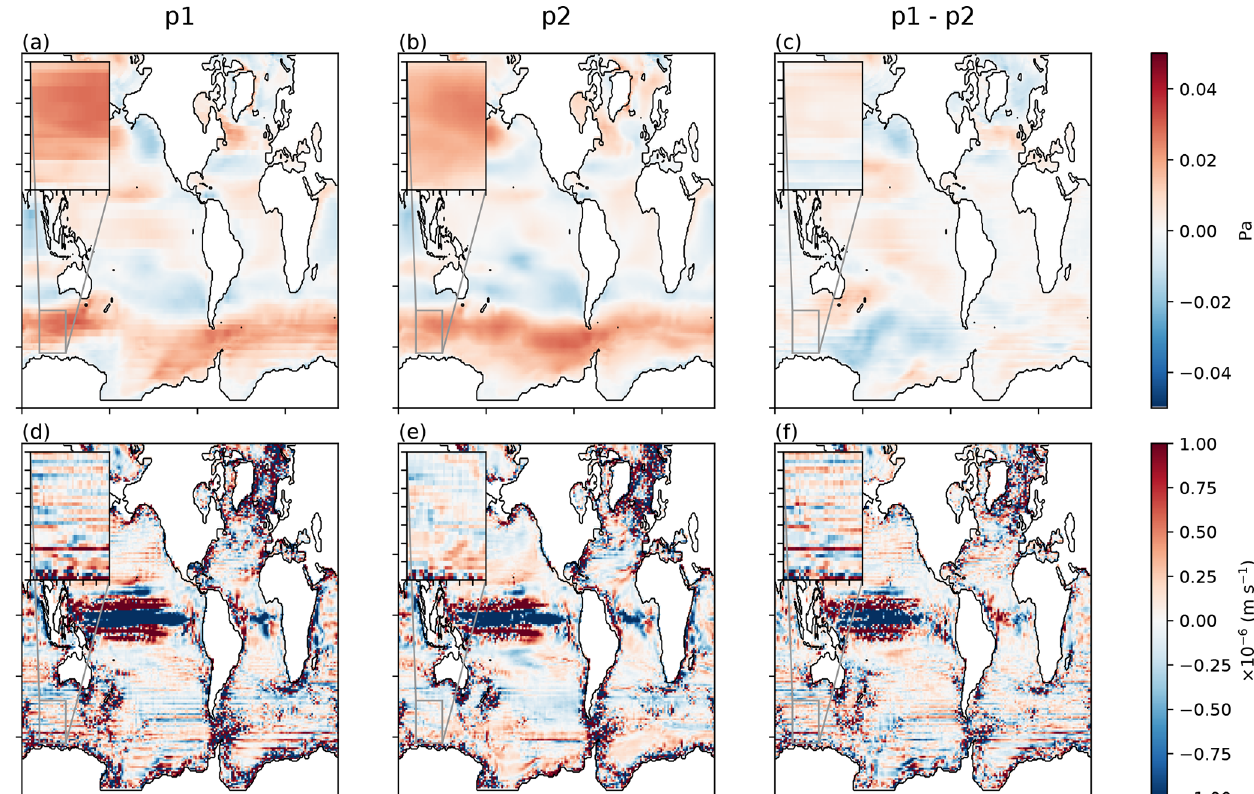
Figure E5. Perturbations of surface ocean zonal wind stress (a, b) and vertical velocity near 100m depth (d, e) computed as the mean over the 20 years centred on CO 2 doubling in the 1pctCO2 experiment, minus the mean over 200 years of the piControl simulation of the p1 (a, d) and p2 (b, e) model variants, and the differences between p1 and p2 (c, f) . Results are shown on the native NEMO grid. The insets show an enlargement of the Southern Ocean south of